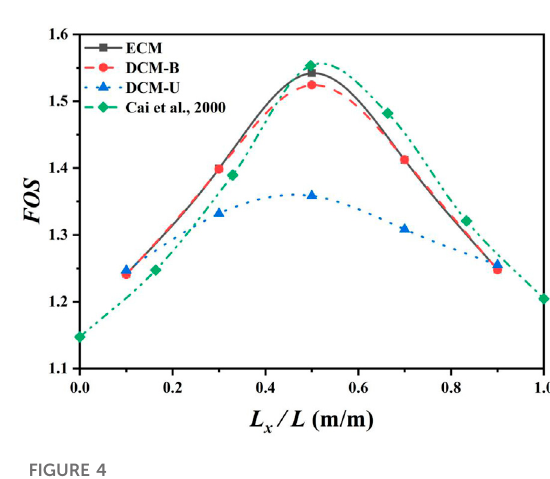
FIGURE 4 Effects of pile position on pile – soil stability considering damage constitutive simulation.